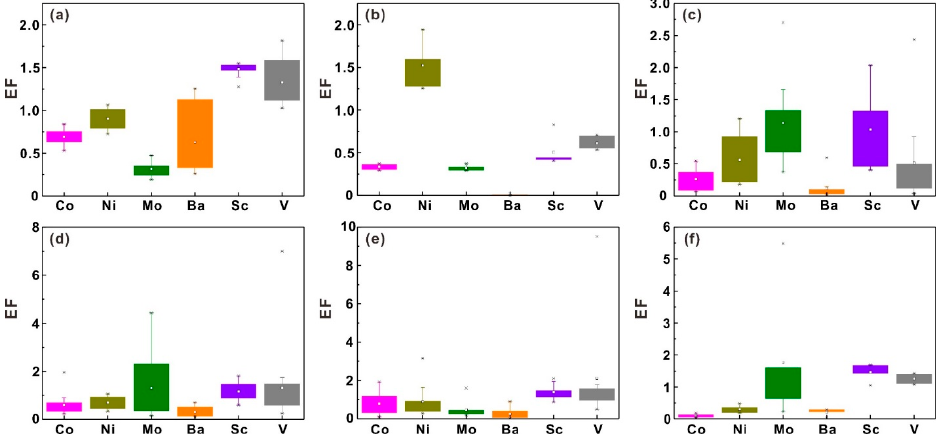
Figure 3. Box plots of heavy metal EF values in six soil profiles, including soil profiles T1 ( a ), T2 ( b ), T3 ( c ), T4 ( d ), T5 ( e ) and T6 ( f ). ( c ), T4 ( d ), T5 ( e ) and T6 ( f